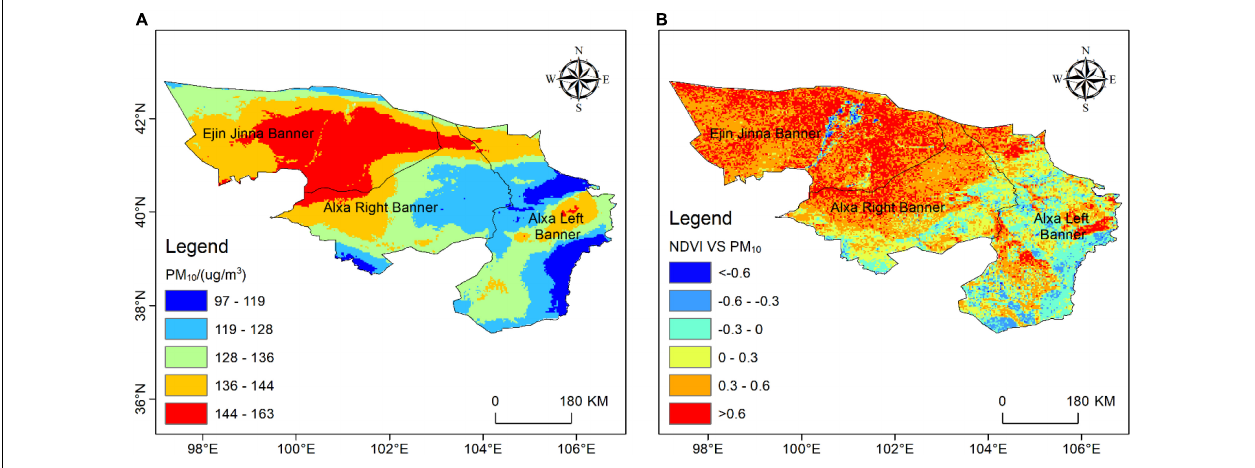
FIGURE 11 | Spatial distribution of overall PM 10 and its correlation with NDVI for 20 years. TABLE 3 | Seasonal and interannual dynamic changes of NDVI and PM 10 in Alxa League from 2015 to 2019. Spring